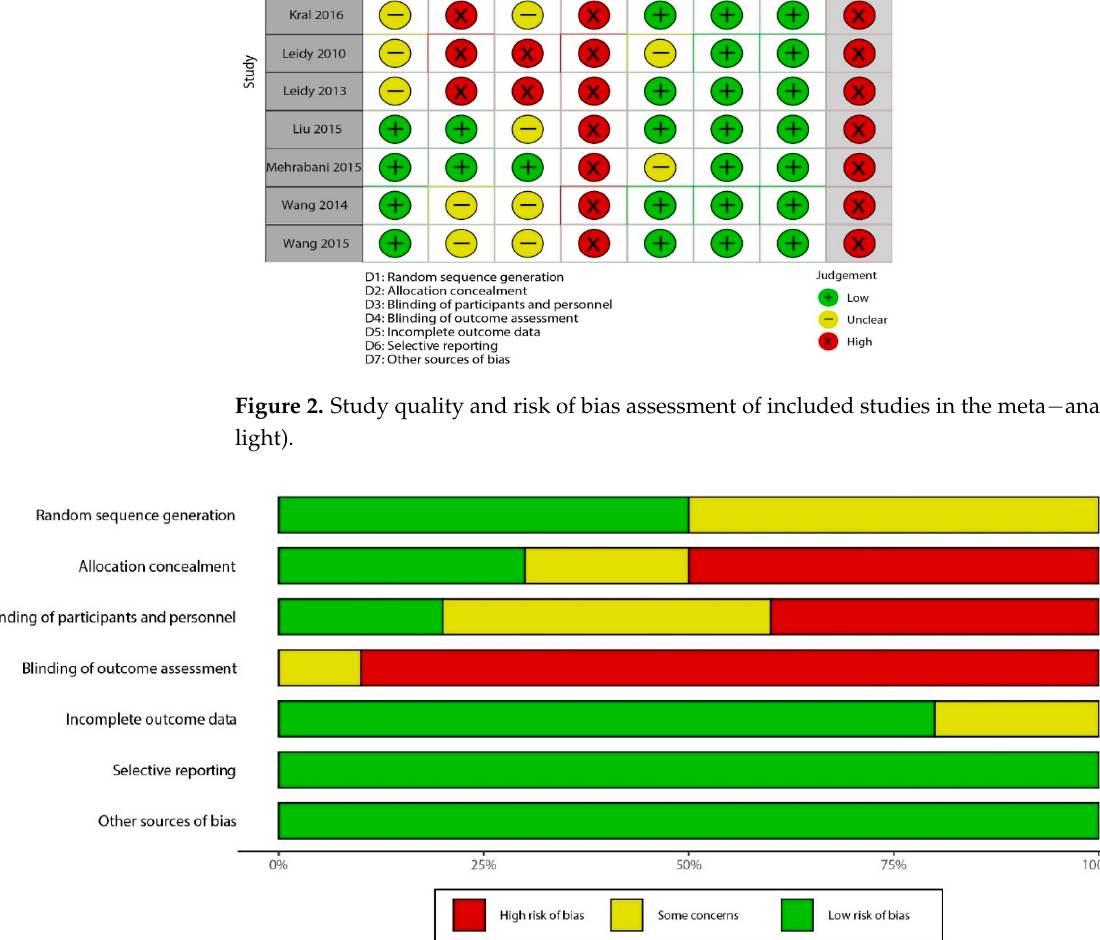
Figure 3. Study quality and risk of bias assessment of included studies in the meta − analysis (summary).